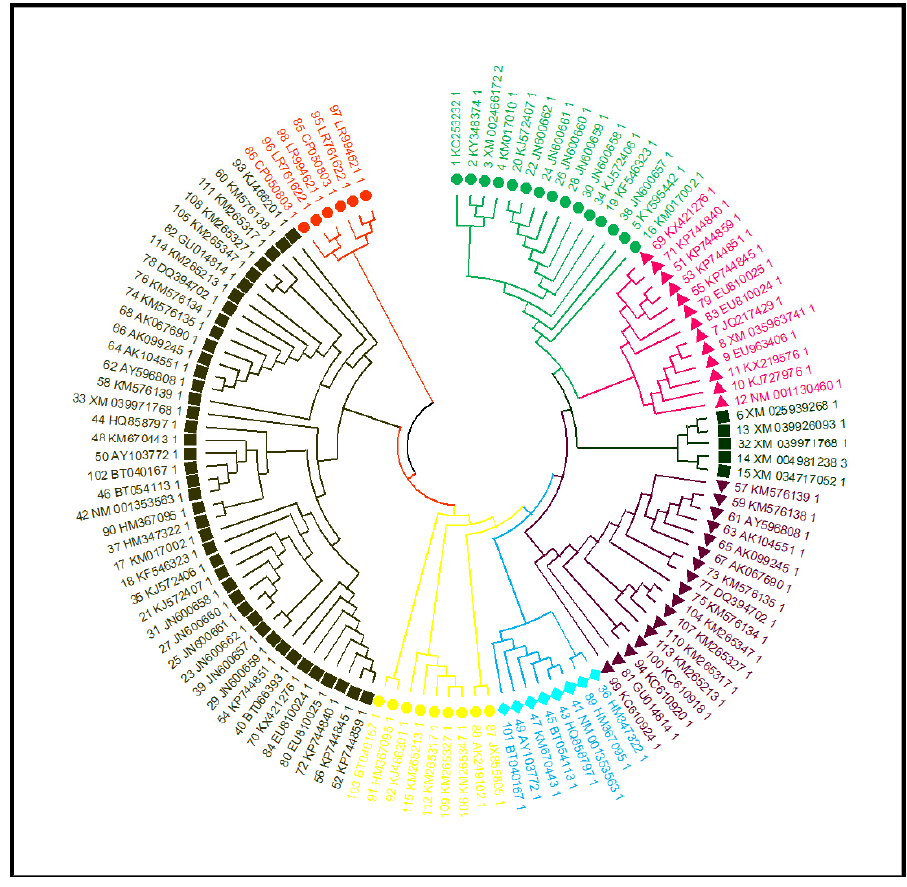
Figure 16. Phylogenetic tree of NAC1 proteins from sorghum using the Mega X (ML method). The colored arcs display different groups. The green circles, pink triangles, green squares, brown triangles, blue stars, yellow circles, brown squares, and red circles represent Sorghum bicolor , Oryza sativa , Miscanthus lutarioriparius , Panicum virgatum , Setaria viridis , Hordeum vulgare , Zea mays , and Digitaria exilis , respectively.